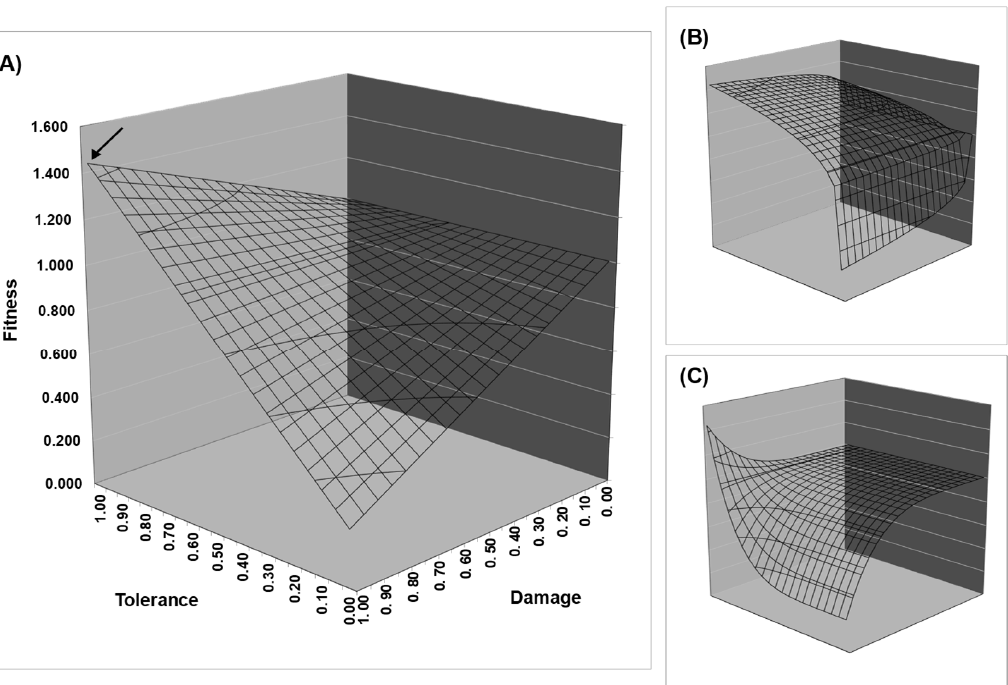
Figure 2. Surface of fitness as function of herbivory and linearity. Charts represent the herbivory term of Equations (1) or (2) as a fitness function of the damage caused by herbivory and tolerance investment. The displayed surfaces were obtained using different linearity values: (A) l = 1.0, (B) l = 5.0, and (C) l = 0.2. Observations: ( i ) Damage has a dual effect on herbivory by scaling the tolerance